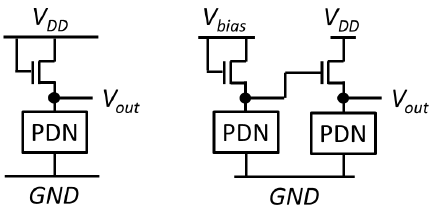
Figure 3: Diode-load logic gate with an always-on enhancement-mode transistor load (left) and pseudo-CMOS logic gate in which the pull-down network (PDN) is repeated twice